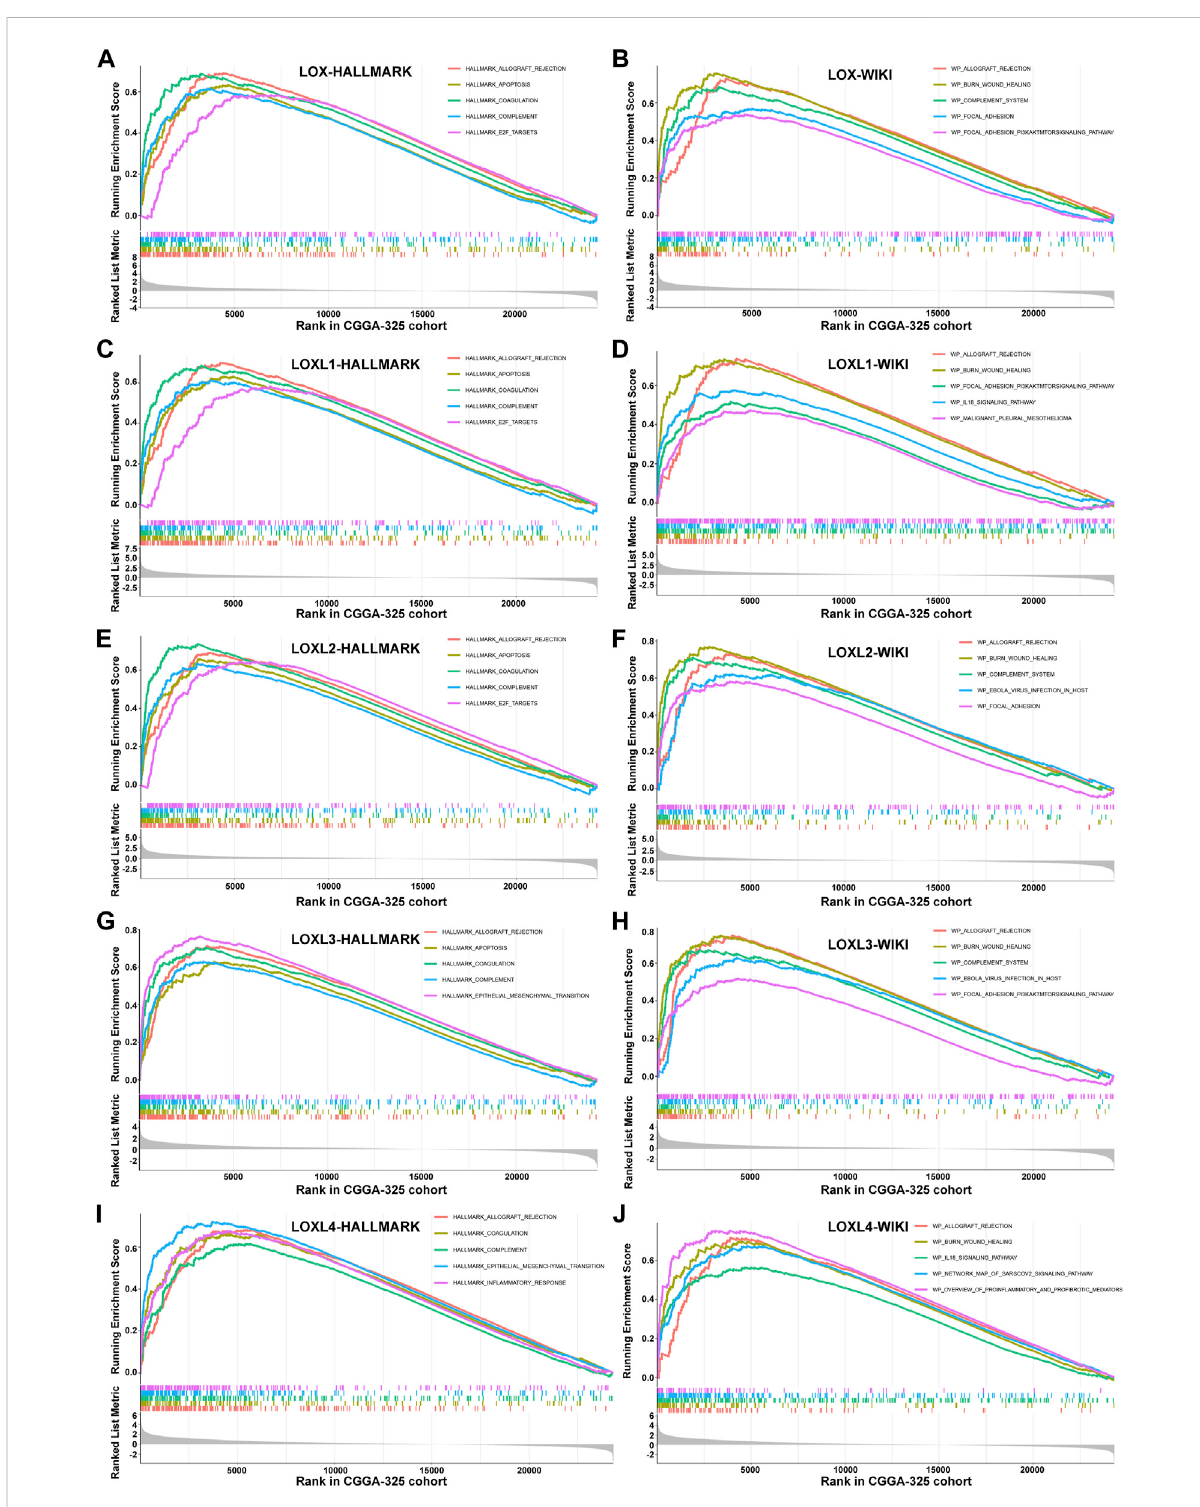
FIGURE 6 Correlations of LOXs and genes together with functional enrichment analysis in glioma in CGGA-325 cohort. (A,C,E,G,I) the top fi ve pathway enrichment with LOXs via GSEA-HALLMARK analysis; (B,D,F,H,J) indication of the top fi ve pathway enrichment with LOXs via GSEA-WIKI